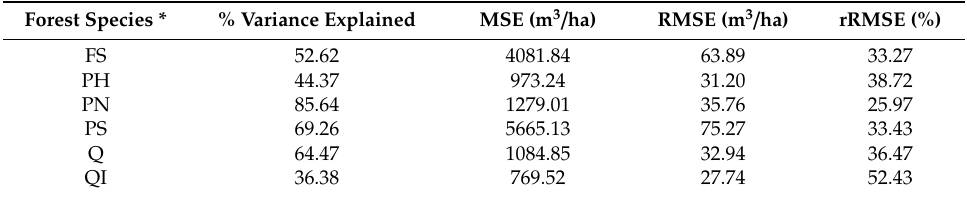
Table A1. Summary of the V models using 2010 airborne laser scanning (ALS) data and SNFI field plots for the six main forest species of La Rioja (Spain). Measures of predictive accuracy were obtained from the out-of-bag (oob) internal error derived from the RF models.